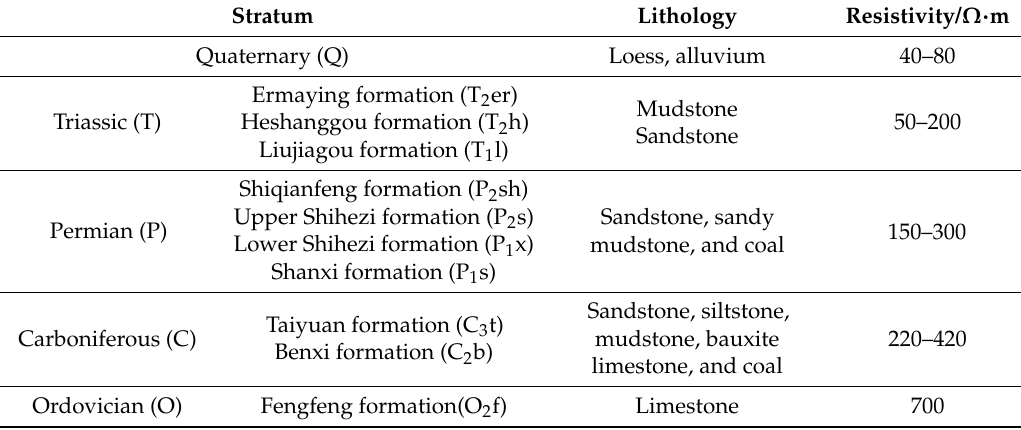
Figure 2. Location and survey line layout of the survey area. Table 1. Stratum parameters of the survey area.